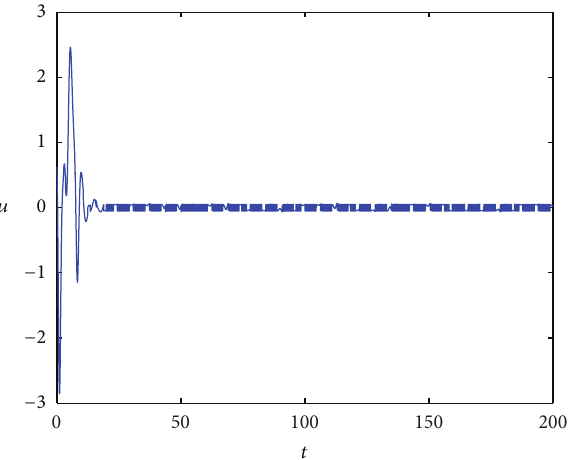
Figure 5: Control input 𝑢 of the slave system